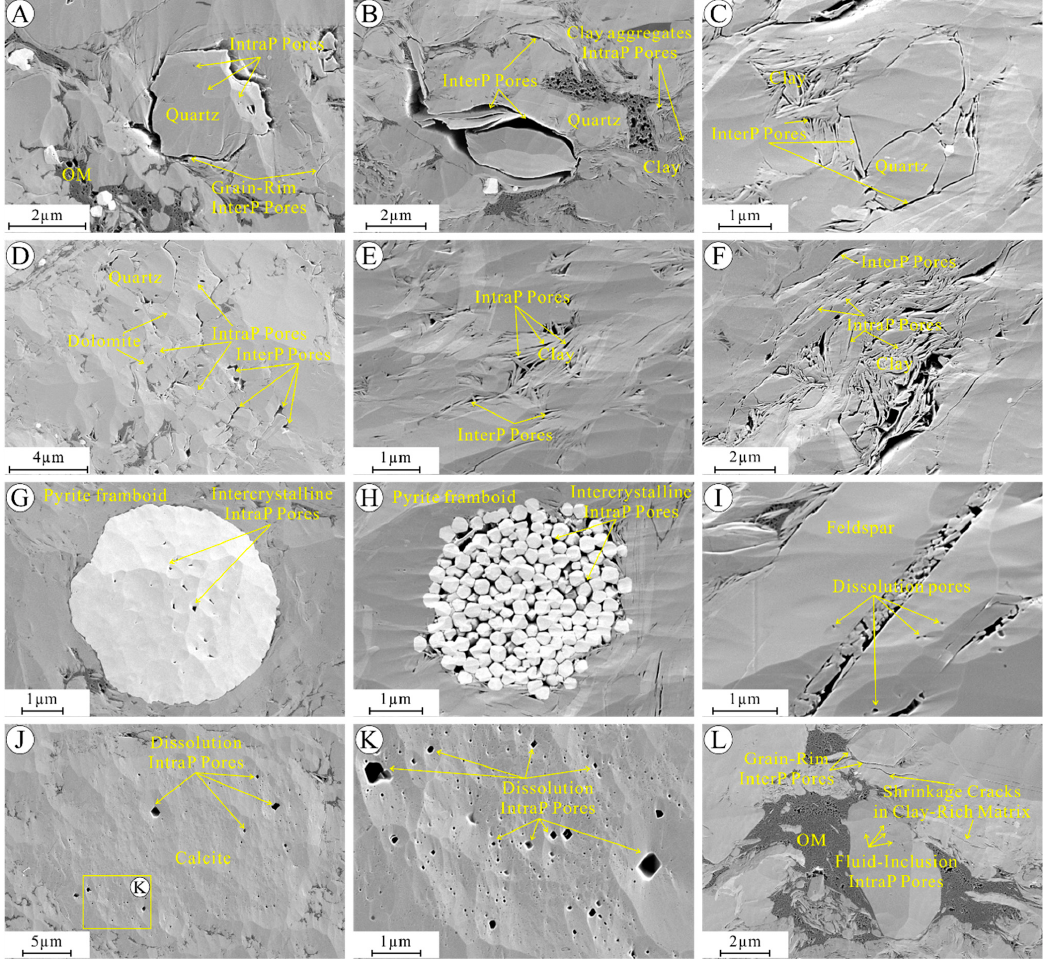
Figure 3. Field emission scanning electron microscopy (FE ‐ SEM) images of interP and intraP pores